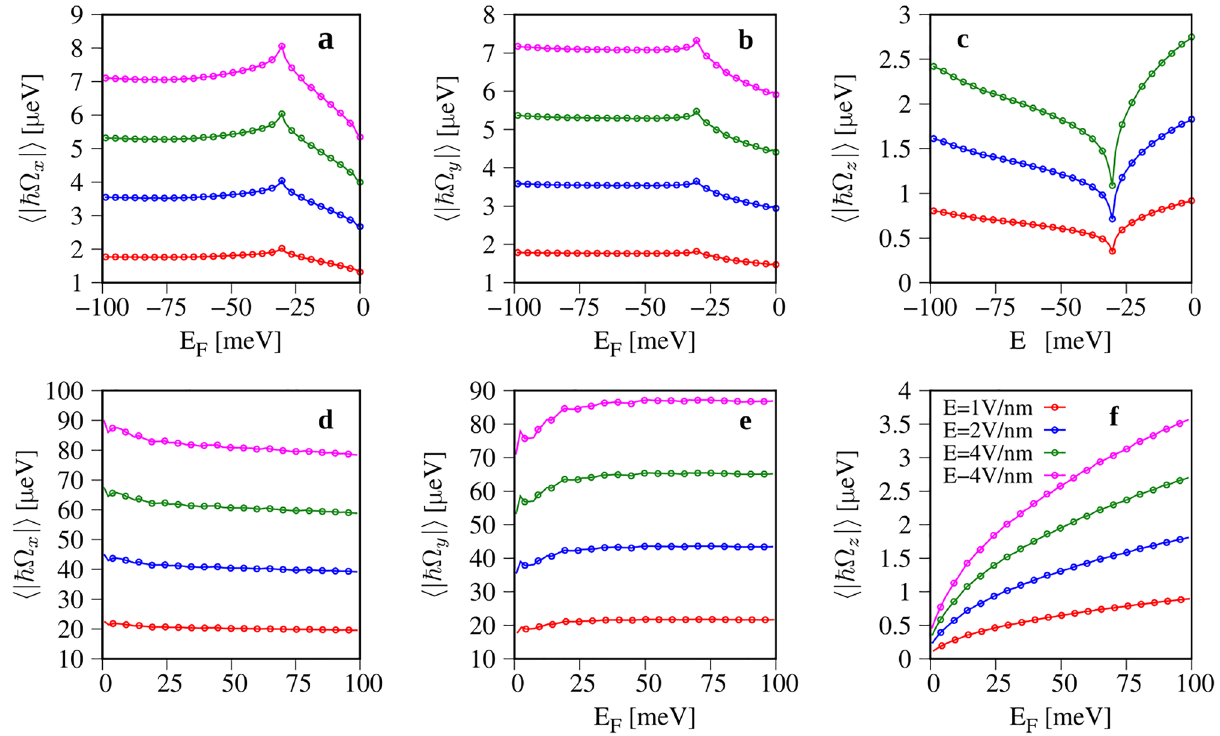
Figure 4. Fermi contour averaged components of the spin–orbit field (cid:31) (cid:31) versus the position of Fermi level E F and for several values of electric field E . Panels ( a – c ) show the x , y , and z components of (cid:31)(cid:31)(cid:31) for the valence band respectively; ( d – f ), same as ( a – c ) but for the conduction band. The Fermi energy is measured with respect to the valence (conduction) band maximum